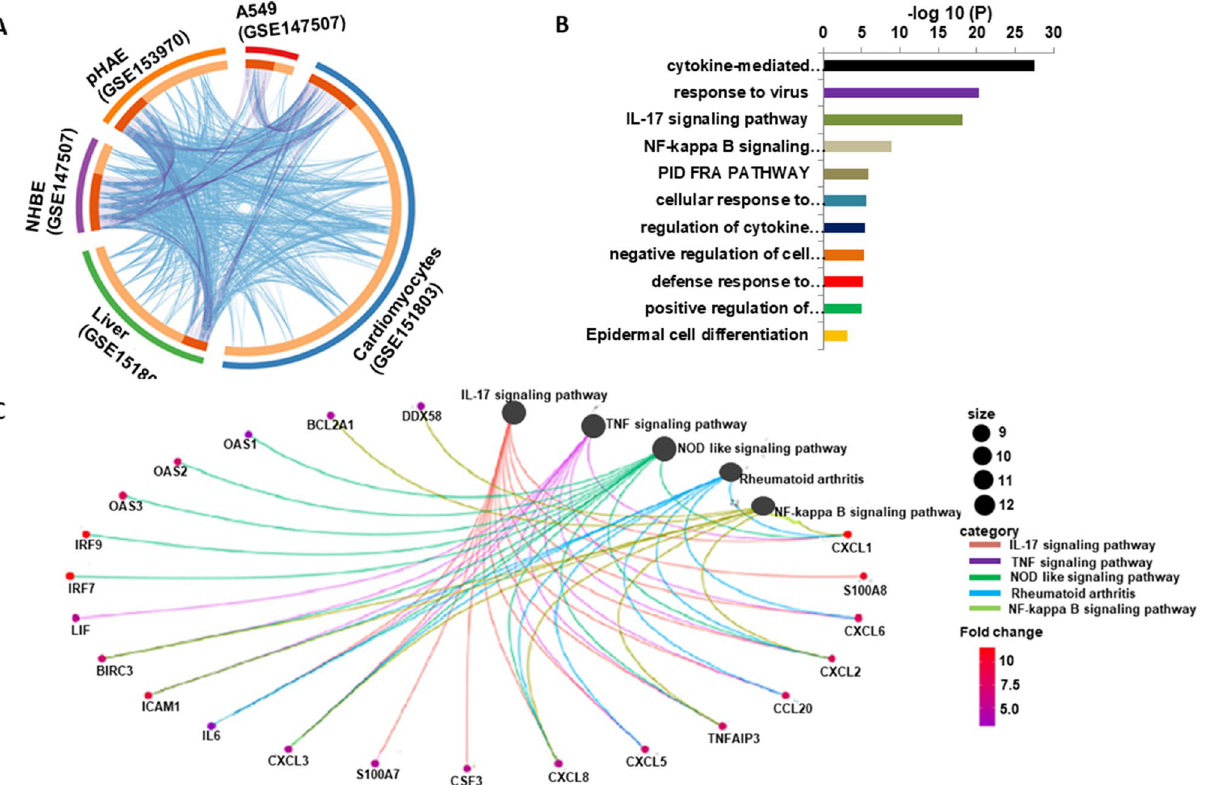
Figure 2. SARS-CoV-2 infection induces inflammatory signaling. ( A ) Circos plot showing the overlapping among genes significantly upregulated upon SARS-CoV-2 infection of different cells. Purple lines represent shared genes by various cells. Blue lines represent the different genes that fall in the same ontology term. ( B ) Hierarchical clustering of the top most enriched KEGG pathways from different datasets. Dendogram is colored by the p values where grey cells indicate the lack of significant enrichment. (C) Circos plot showing collated shared genes from different datasets, genes are assigned to their designated KEGG